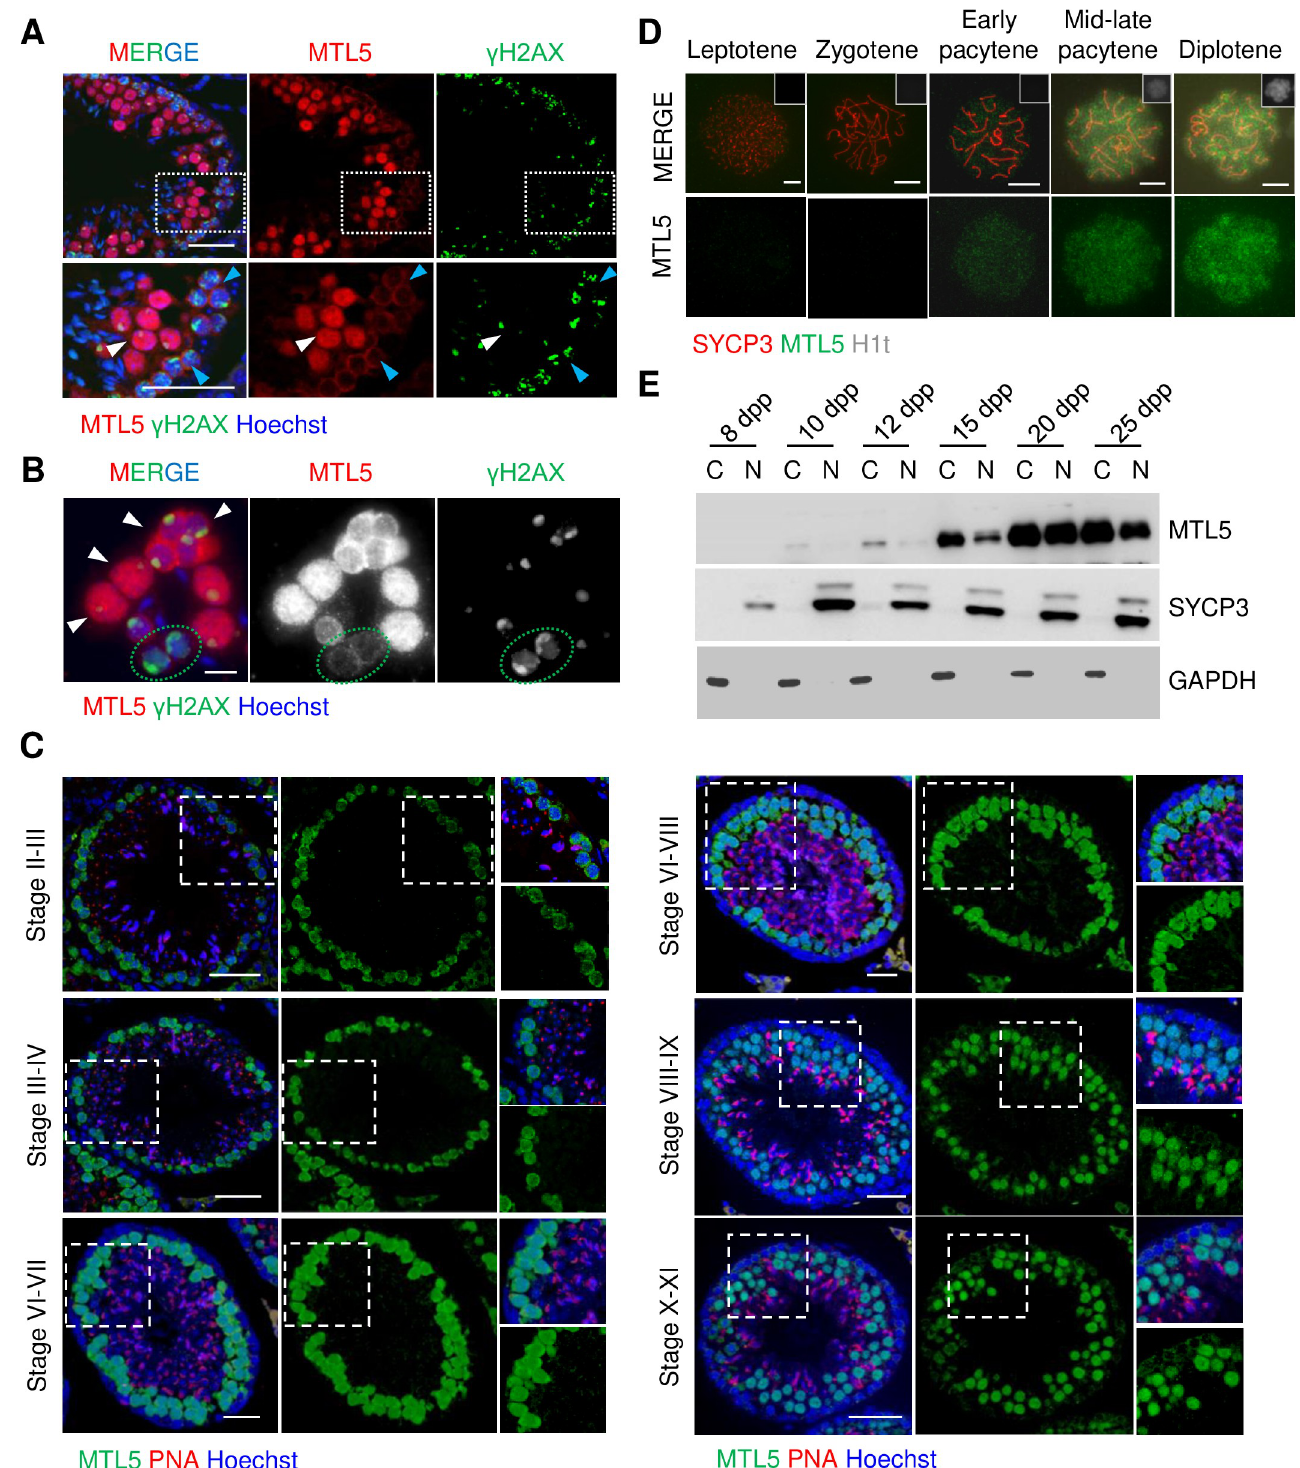
Fig 1. The dynamic localization of MTL5 in spermatocytes of meiotic prophase I. (A) Immunostaining of MTL5 (red) and γ H2AX (green) in testicular sections of 10-week-old wild-type mice. Nuclei were counterstained with Hoechst 33342 (blue). Enlarged views (bottom) are indicated by white boxes (top). White arrowheads indicate pachytene or diplotene spermatocytes. Blue arrowheads indicate leptotene or zygotene spermatocytes. Scale bars, 50 μ m. (B) Immunostaining for MTL5 (red) and γ H2AX (green) in smeared testicular cells of 10-week-old wild-type mice for MTL5 (red) and γ H2AX (green). Nuclei were